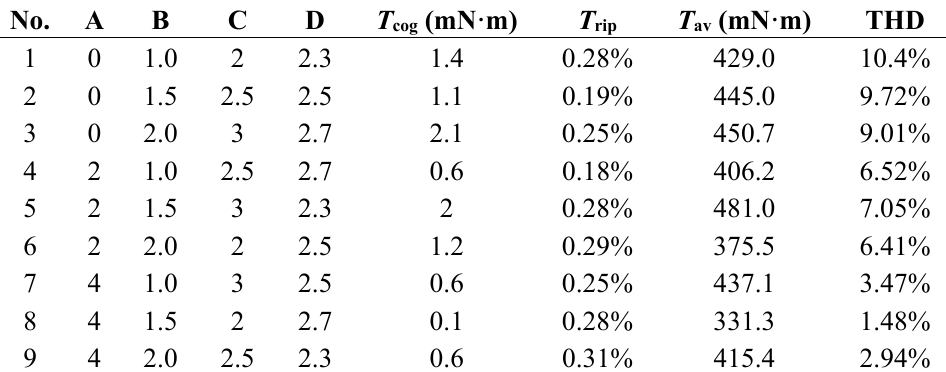
Table 9. Results of nine